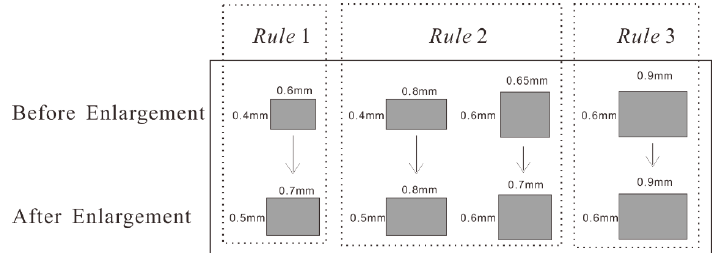
Figure 12. Three rules for enlargement of individual buildings at scales of 1:25,000 and 1:50,000.